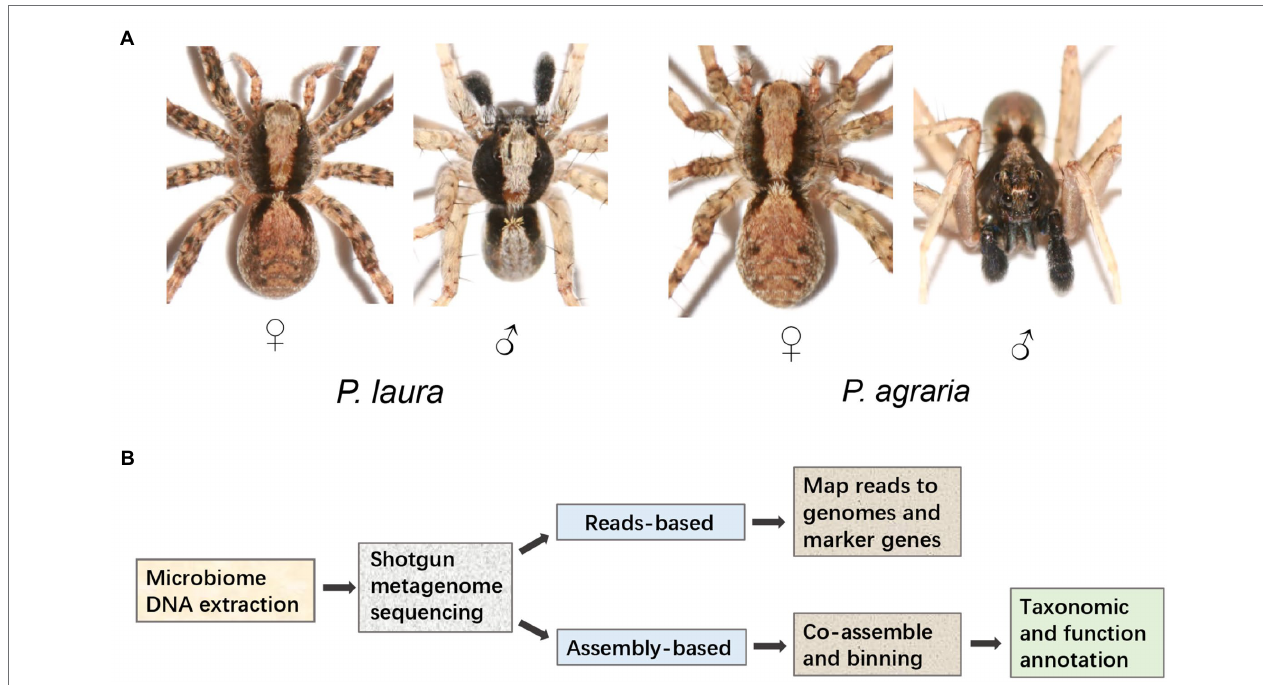
FIGURE 1 | Study cohort and design. (A) Morphological characteristic of Pardosa laura and Pardosa agraria spiders. (B) Metagenomic analysis